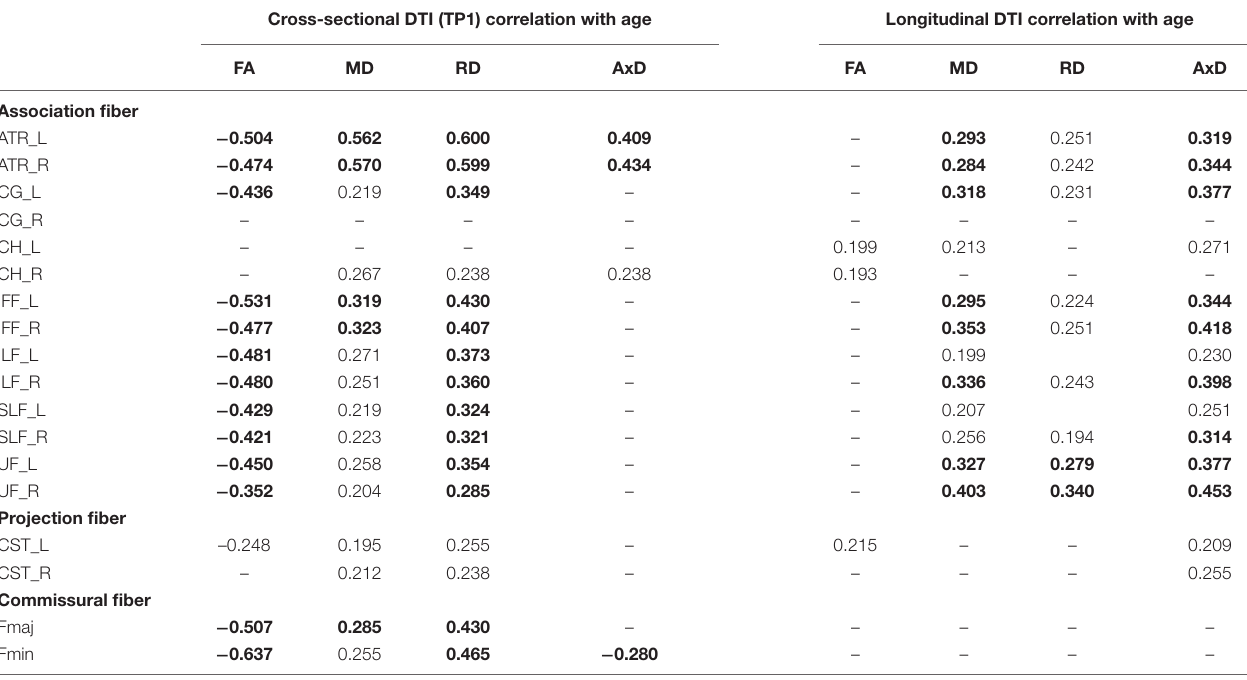
TABLE 3 | The significant Pearson correlation r values for age and DTI (cross-sectional and longitudinal ratio scores). Cross-sectional DTI (TP1) correlation with age Longitudinal DTI correlation with